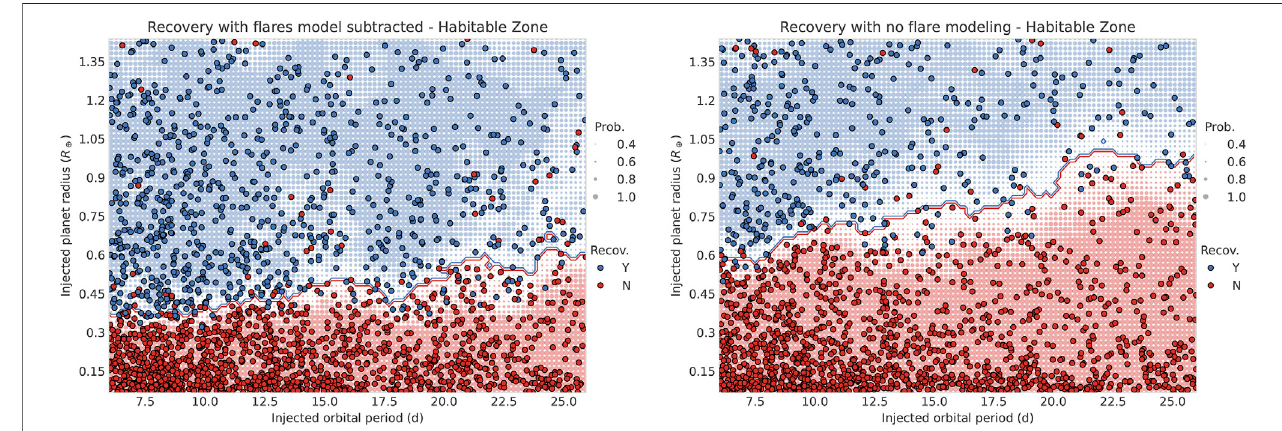
FIGURE 5 | An expanded planet injection and recovery test spanning the entire Habitable Zone of Proxima Centauri. On the left, we show results with the fl are model subtracted from the light curve, which provides signi fi cant improvement as compared to results without subtracting off the fl ares, as shown on the right.